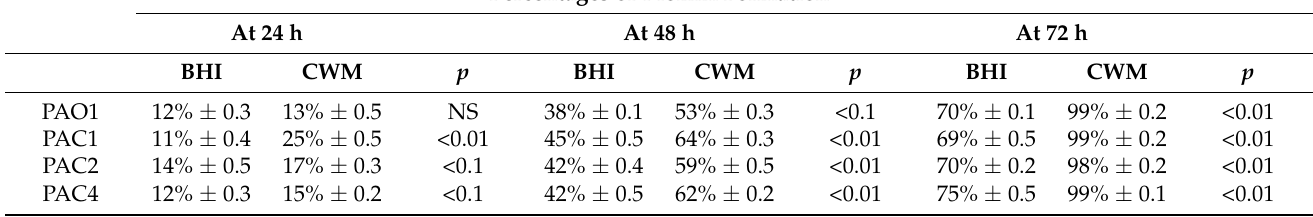
Table 3. Kinetics of biofilm formation by P. aeruginosa strains in the BioFlux TM system. The percent- ages of biofilm formation were determined for the reference strain PAO1 and three clinical strains, PAC2, PAC3 and PAC4, at 24 h, 48 h and 72 h post-incubation in BHI and CWM after six independent experiments. Results are presented as the mean ± standard deviation. Statistics were performed using a t -test in GraphPad Prism version 9.2 to compare the percentage of biofilm formed in BHI and CWM for each time